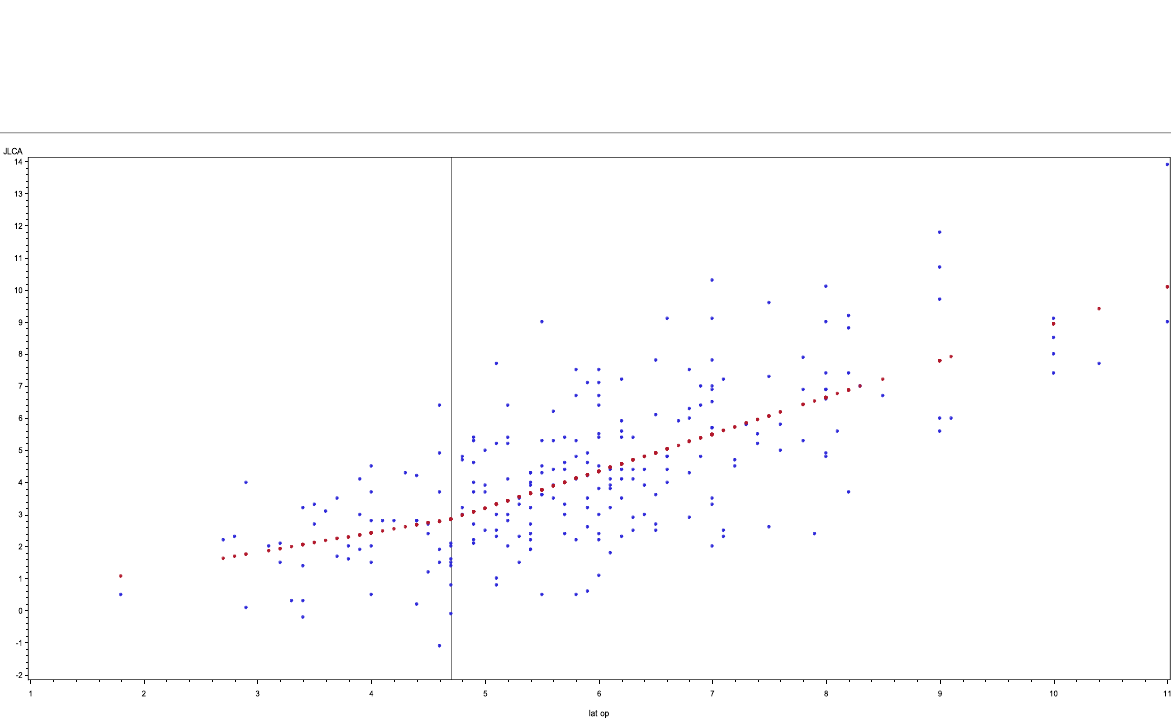
Fig. 4 In this graph, the lateral opening (measured in mm) is plotted against the JLCA (measured in degrees). A positive correlation is found between the two variables. However, a difference in gradient is clearly seen with the cut-off point being 4.7 mm. The gradient beyond this point is almost double that compared to the gradient before this